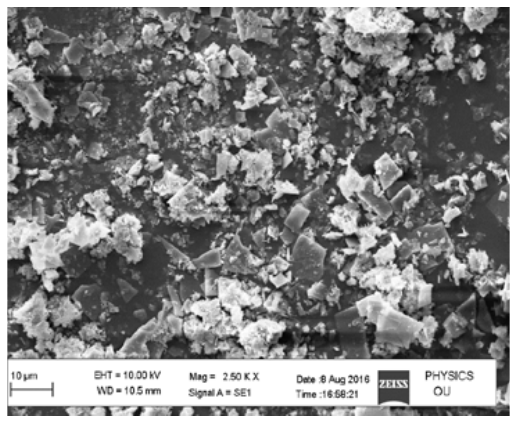
Fig. 5: SEM image of Ir-doped TiO